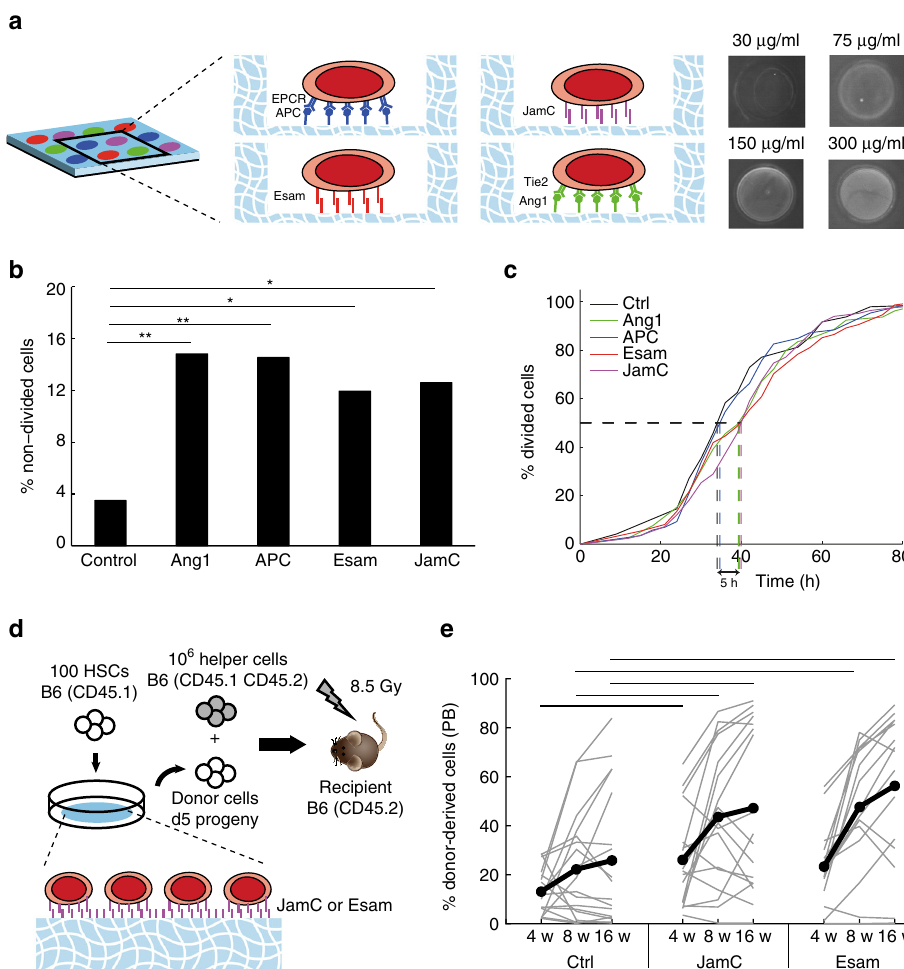
Fig. 5 HSCs exposed to an arti fi cial in vitro niche functionalized with cell-cell interaction molecules slow down proliferation and retain in vivo reconstitution potential. a PEG microwell array functionalized with APC, JamC, Esam, or Ang1. Immuno fl uorescent images of JamC-functionalized microwells stained with anti-JamC antibody and fl uorescently conjugated anti-rat antibody. b Percentage of cells undergoing no divisions over 120 h in non-functionalized microwells (control) or microwells functionalized with APC, Ang1, Esam or JamC. Graph indicates percentages of cells. Dead cells excluded. * p ≤ 0.05, ** p ≤ 0.01 in Fisher ’ s exact test. c Cumulative histogram of time until fi rst division for HSC cultured in non-functionalized microwells (control, black ) or microwells functionalized with APC ( blue ), Ang1 ( green ), Esam ( red ) or JamC ( purple ). Number of single cells is for control n = 86, for Ang1 n = 162, for APC n = 165, for Esam n = 134, for JamC n = 143. d HSCs were cultured for 120 h in non-functionalized microwells (control) or microwells functionalized with JamC or Esam and the progeny of 100 cells was recovered and injected in lethally irradiated mice. Blood of recipient mice was analyzed at 4, 8, or 16 weeks. e Graph indicates percentage of donor-derived cells at 4 weeks, 8 weeks, or 16 weeks in mice engrafted with cells exposed to non-functionalized microwells (control) or microwells functionalized with JamC or Esam. Graph represents pooled data from two independent experiments. Gray lines indicate percentage of donor-derived cells for single mice of both experiments. Black line indicates mean for all animals. Number of recipients surviving at 16 weeks for both experiments is n = 18 for control, n = 17 for JamC, and n = 15 for Esam. * p ≤ 0.05, ** p ≤ 0.01. Bars indicate signi fi cance at p ≤ 0.05 in non- parametric Mann – Whitney test. See also Supplementary Figs. 6 – Methods Mice . All animal experiments were performed in compliance with the Swiss law after approval from the local (Service Ve ́ te ́ rinaire de l ’ Etat de Vaud) and federal authorities (VD 2135.3a/ETV 26747, VD 2242.2/ETV 28153). C57Bl/6J and C57Bl/ 6J Ly5.1 female and male mice, in the age of 8 – 12 weeks, were purchased from the Charles River Laboratories International and maintained at the Center for Studying Living System (CAV) at the EPFL in microisolator cages. Mice were provided continuously with sterile food, water, and bedding. Flow cytometry and cell sorting . Hematopoietic stem and progenitor cells were isolated from fl ushed bone marrow of 8 – 12 week C57Bl/6 mice. Erythroid cells were eliminated by incubation with red blood cell lysis buffer (Biolegend). Lineage depletion (CD3, B220, Ter-119, CD11, Gr-1) was performed using the Hematopoietic Progenitor Cell Enrichment set (BD Biosciences). Cells were stained with SAV-PETxRed (1:200, Life Technologies), Kit-PECY7 (1:200, 2B8, BioLegend), Sca-1-APC (1:100, D7, BioLegend) or – PerCPCY5.5 (1:200, E13-161.7,